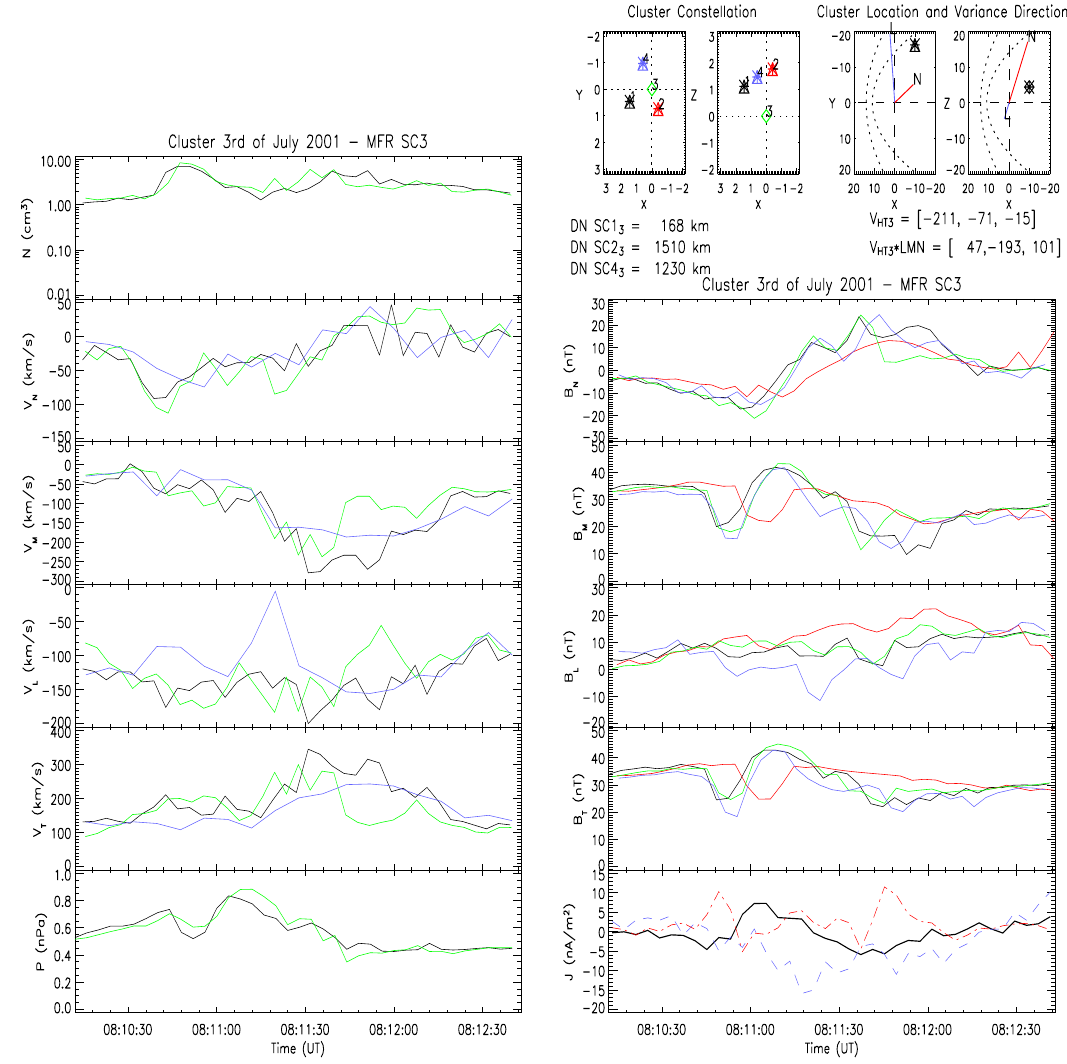
Fig. 16. Plasma (left) and magnetic field (right) observations between 08:10:12–08:12:45 UT in the boundary normal coordinates of sc3. Figure uses same format as Fig.